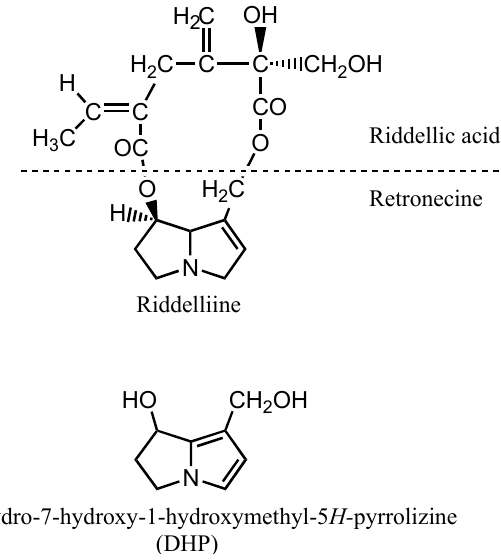
Scheme 1. Chemical structures of riddelliine and its reactive metabolite 6,7-dihydro-7-hydroxy-1- (hydroxymethyl)-5 H -pyrrolizine